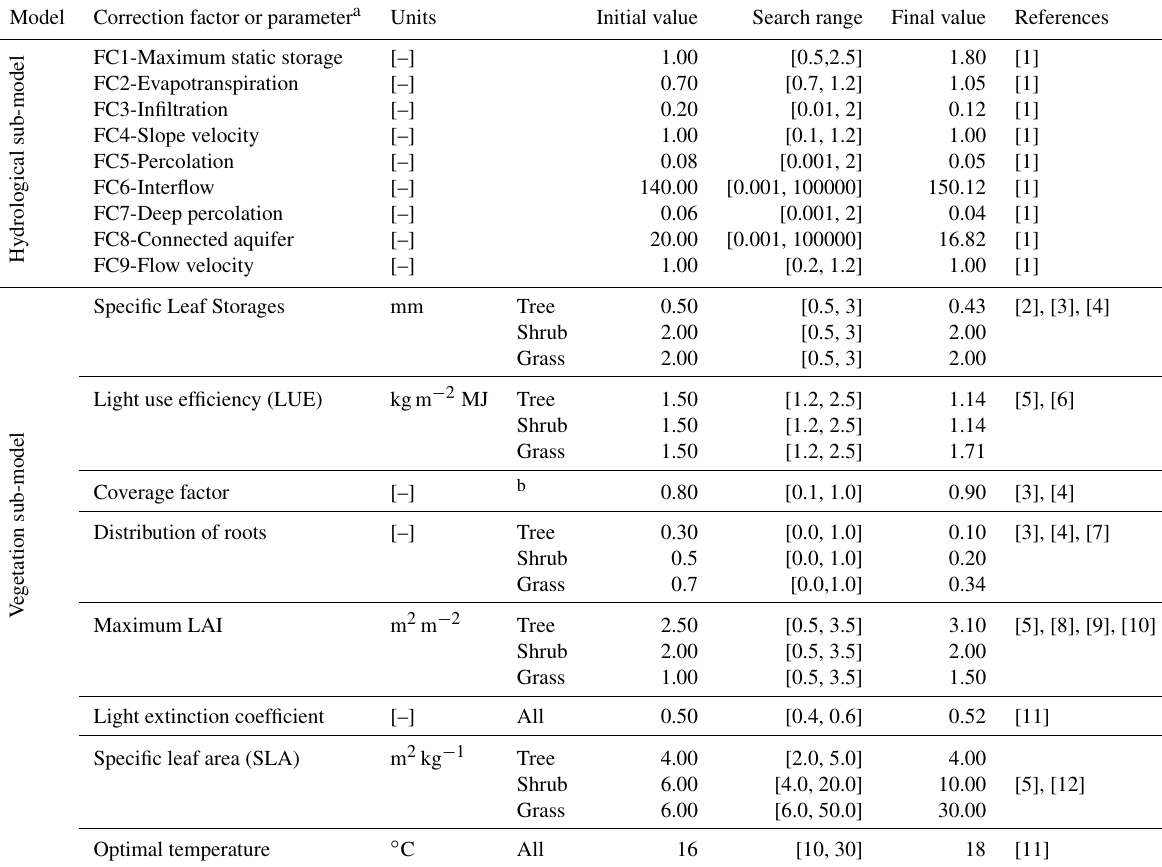
Table 1. Summary of the initial values, the search range and the final value of the parameters or correction factors of both sub-models (hydrological and dynamic vegetation sub-models) as well as the units and the reviewed references.